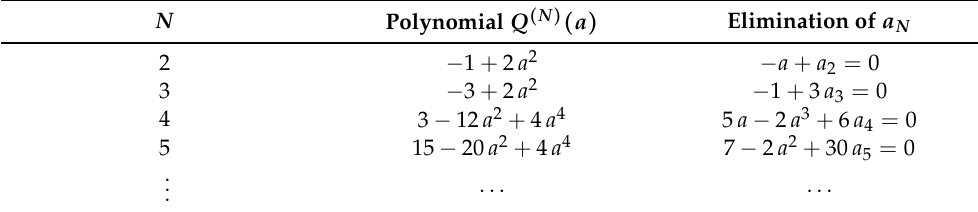
Table 2. QES values a = a 2 = − d determined as zeros of polynomials Q ( N ) ( a ) (odd-parity case). N Polynomial Q ( N ) ( a ) Elimination of a N 2 − 1 + 2 a